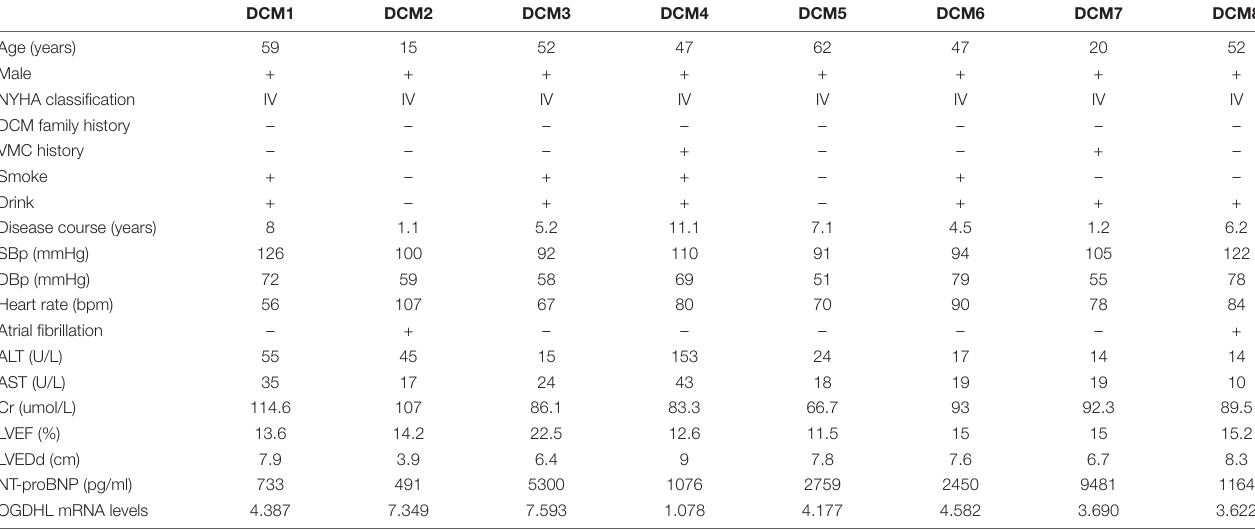
TABLE 1 | Clinical characteristics of 8 dilated cardiomyopathy (DCM) patients before heart transplantation. DCM1 DCM2 DCM3